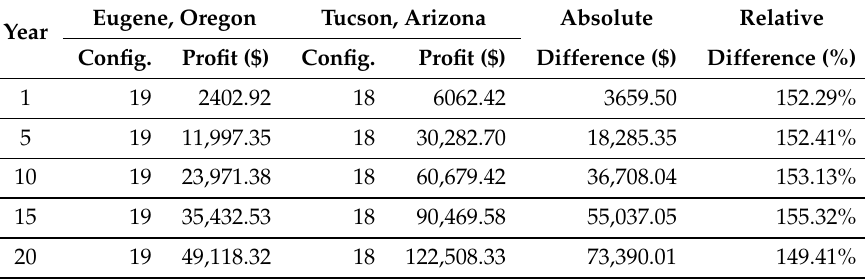
Figure 13. Profit of different configurations have same initial capital cost at two locations. Table 6. Highest profit at both locations in different